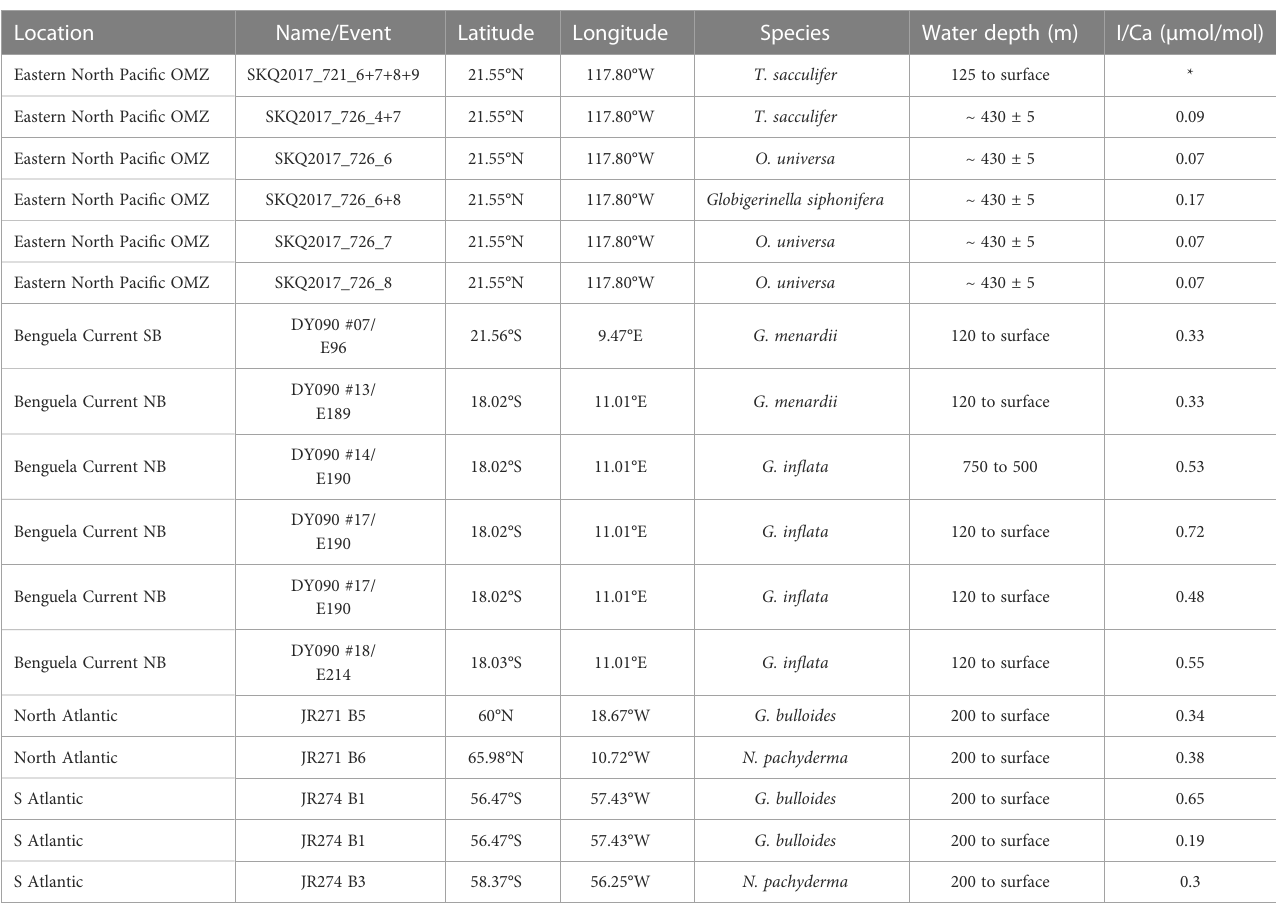
TABLE 1 Sample details, locations and I/Ca values of plankton net